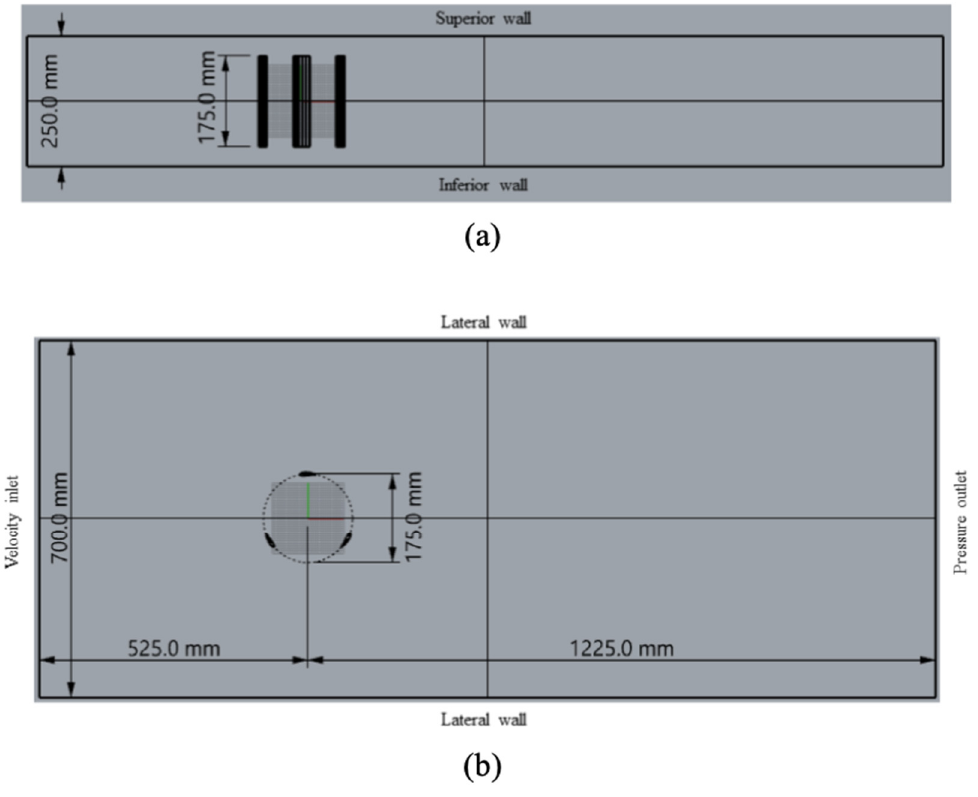
Figure 8. Computational domain for the Darrieus turbine: ( a ) side view and ( b ) top view.